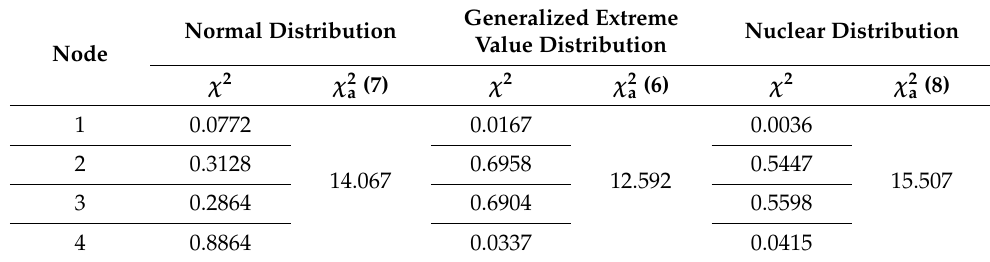
Table 7. Hypothesis test parameters for life distributions.